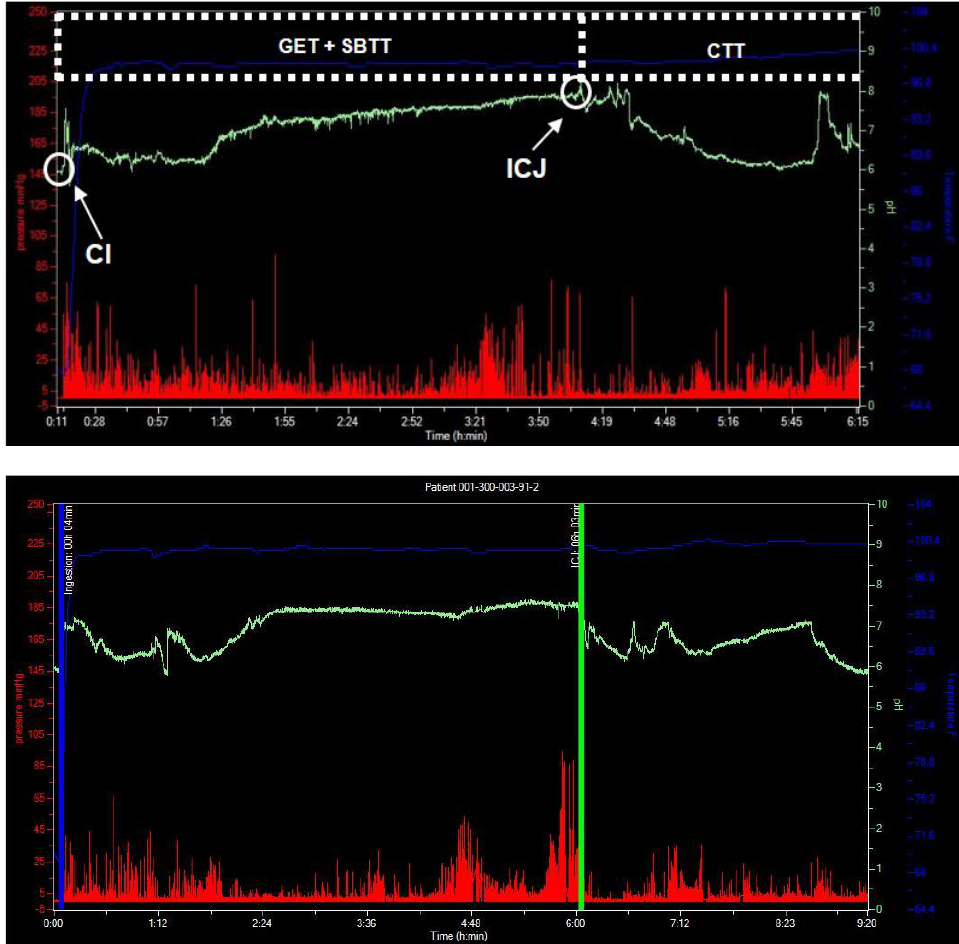
Figure 13. pH (green), temperature (blue), and pressure (red) curves in a fasted state after sleeve gastrectomy (SG, above ) and Roux-en-Y gastric bypass (RYGB, below ), measured by Smartpill TM . CI: capsule intake, GET: gastric emptying time, SBTT: small bowel transit time, ICJ: ileocecal junction, CTT: colon transit time.